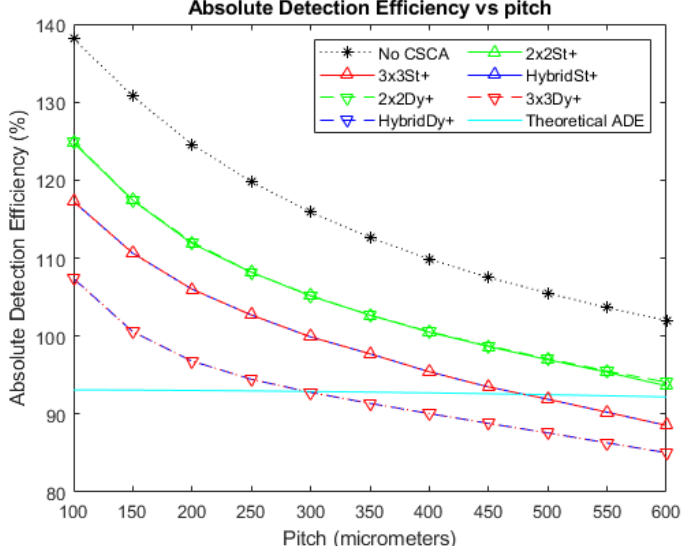
Figure 3. A plot of Absolute Detection Efficiency (ADE) versus pixel pitch at an incident photon flux of 10 6 photons mm −2 s −1 . The Hybrid and 3 × 3 CSCAs perform indistinguishably according to this metric, resulting in significant overlap. Similarly, the 2 × 2 dynamic and static CSCAs overlap almost entirely at this flux level. The case where no CSCA is applied is also shown, along with the theoretical ADE value proposed earlier as a reference.